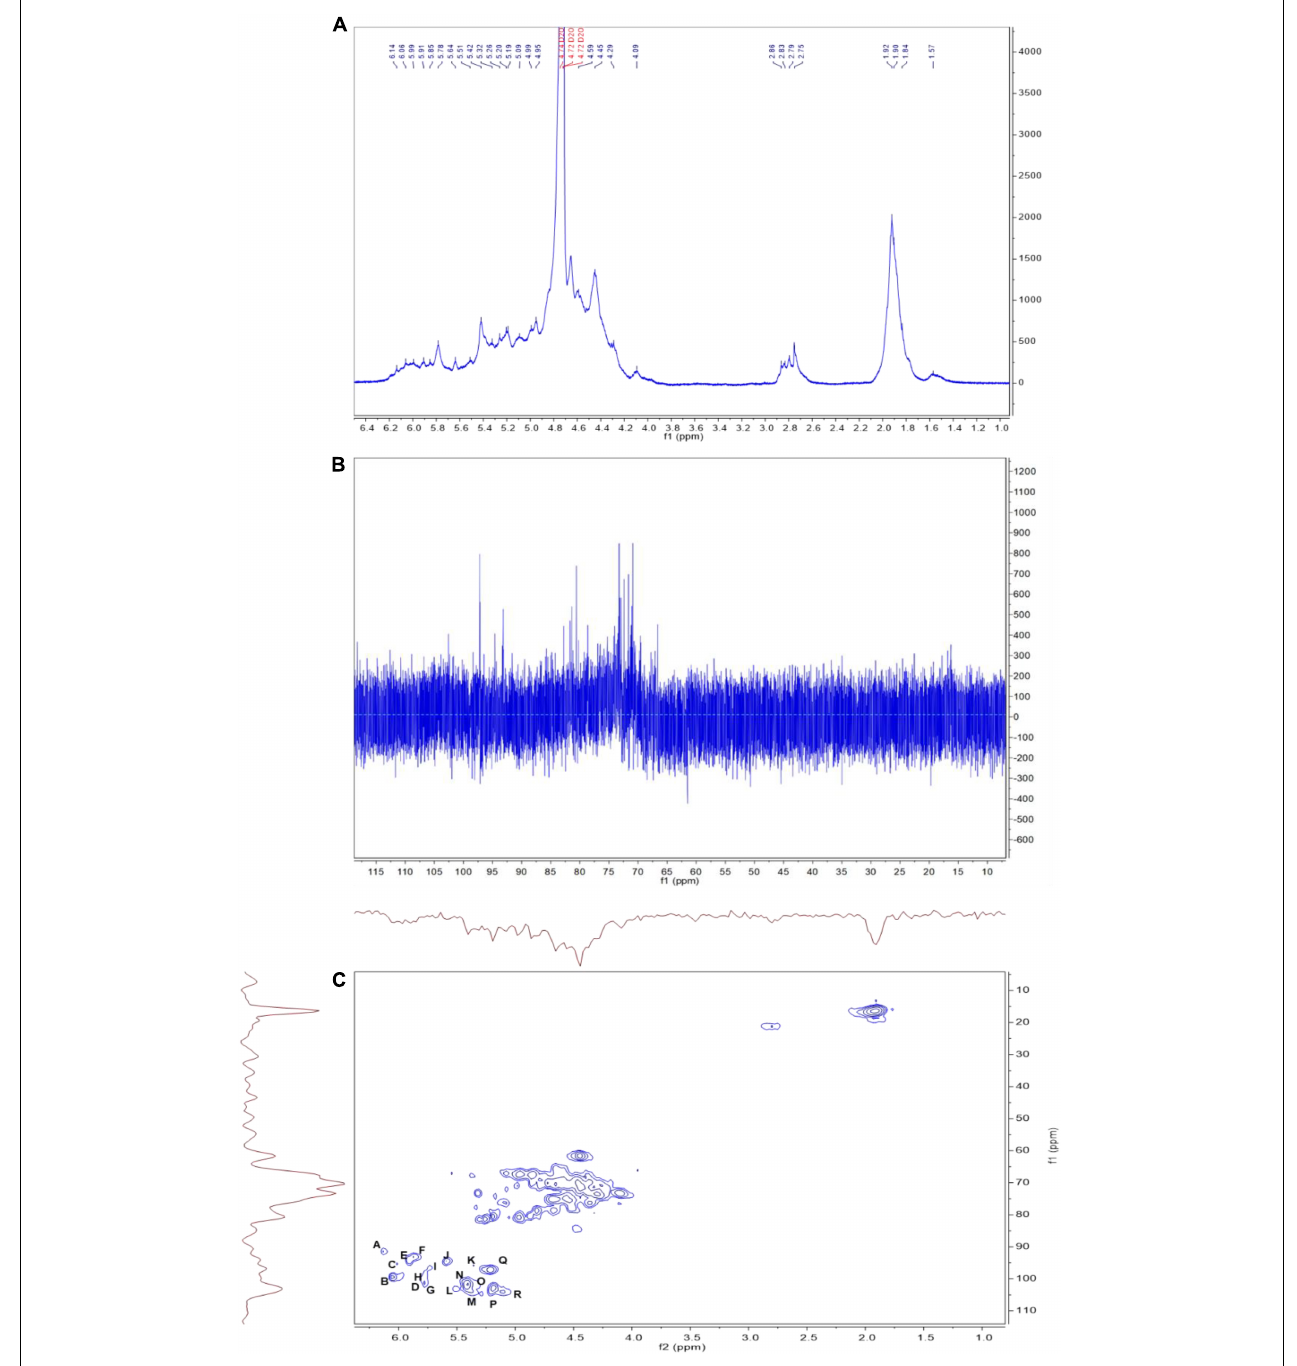
FIGURE 6 | The 1 H (A) , 13 C (B) , and heteronuclear singular quantum correlation (HSQC) (C) nuclear magnetic resonance (NMR) spectrum of LJPS in D 2 O solution at 25 ◦ C. A, B, C ... R in (C) indicate the correlation between carbon 1 (C1) and hydrogen 1 (H1) of residue A. The order of residues A, B, C...R is consistent with that in Table 4